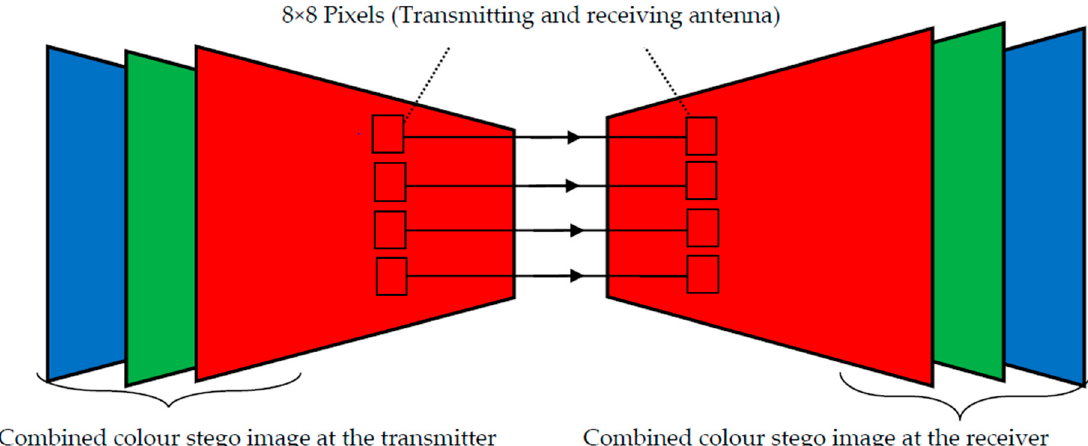
Figure 2. Screen-Camera based visual MIMO Communication Illustration.